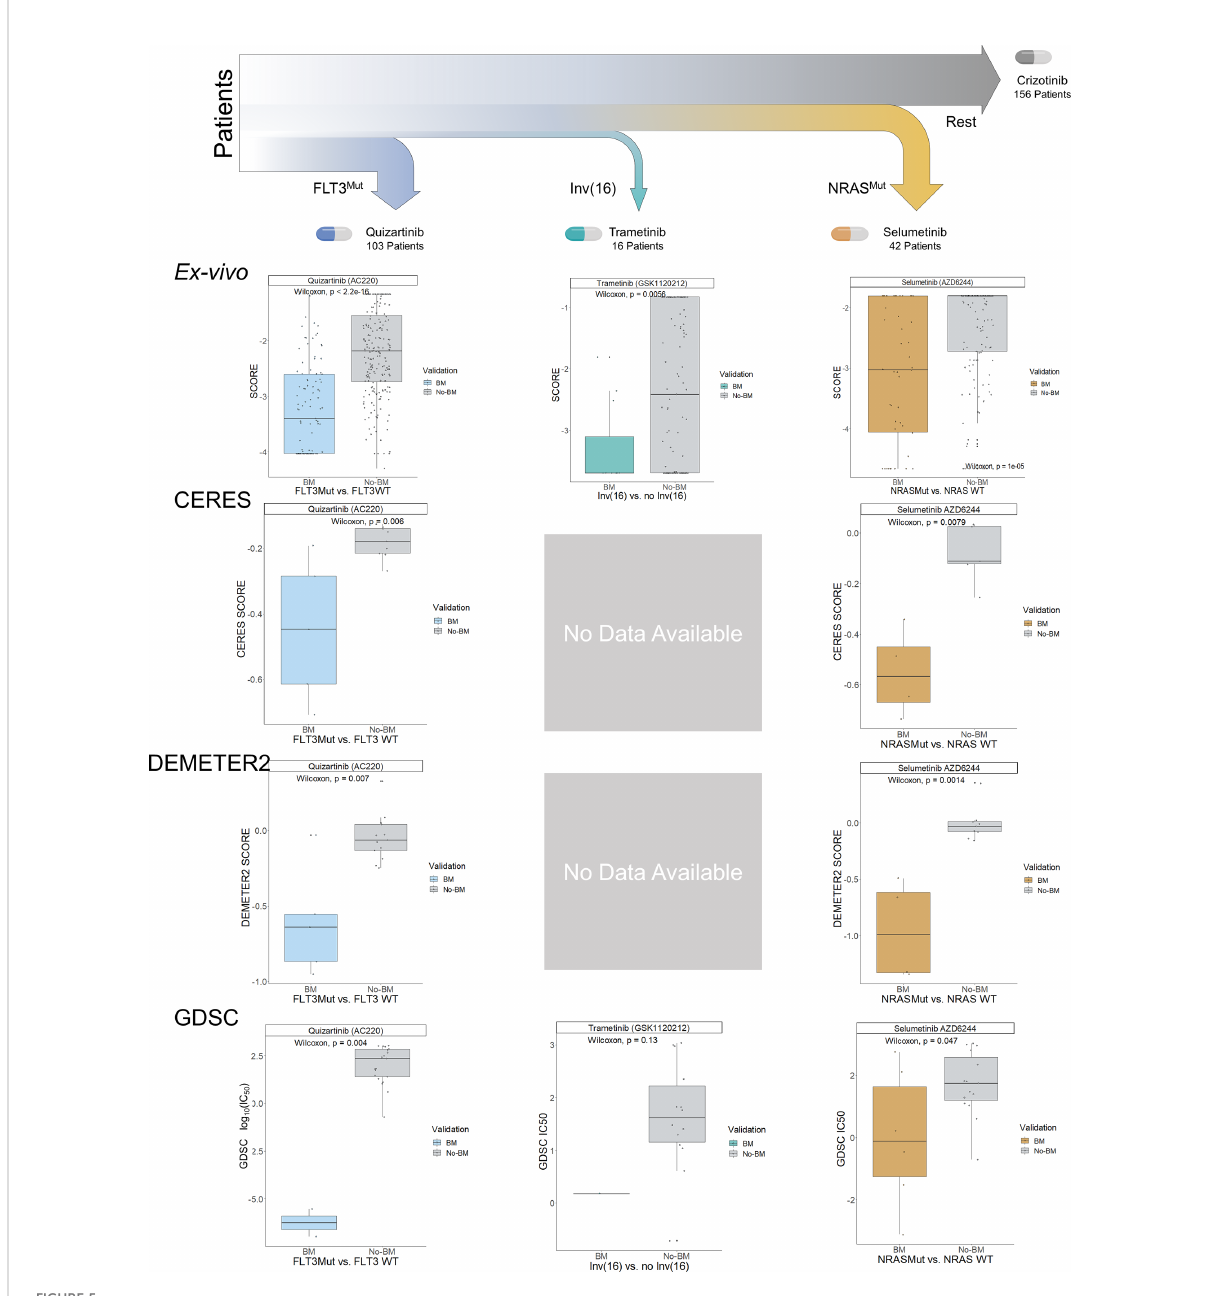
FIGURE 5 DecisionTreefortheProposedPatientStrati fi cationusingMOM.MILP fromMOMobtaineda hierarchicalclinicalguideline forpatient strati fi cation consistingof 4 differentsubgroups. Eachof themisdenotedby abiomarkerandrepresented by color(blue, turquoise,orange,andgrey).These subgroups were validatedintheBeatAMLex-vivocohort,CERES, DEMETER2, andGDSC. Boxplotsshowtheresultsofthevalidation. They-axisrepresentsthe essentialityscore fromthe different experimentsand thex-axisrepresentsthebiomarkerpresence-absenceofthesamples. Thevalidation wasperformed sequentially,alreadytreated samplesfromprevioussubgroupswereexcludedinthefollowingsubgroupsi.e. sampleswith FLT3 Mut (blue)fromthe fi rst boxplotarenotplottedinthe non-biomarker(grey)inthesecondboxplot. CERESandDEMETER2donothave experimentswithcell